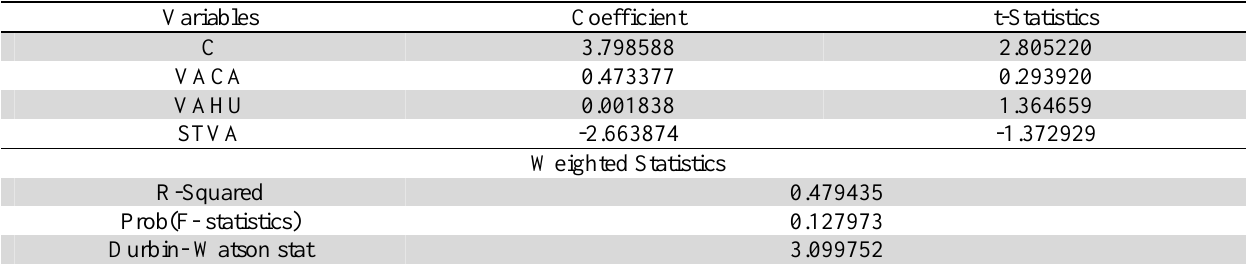
The results of Cross- section random effects for Hypothesis 1